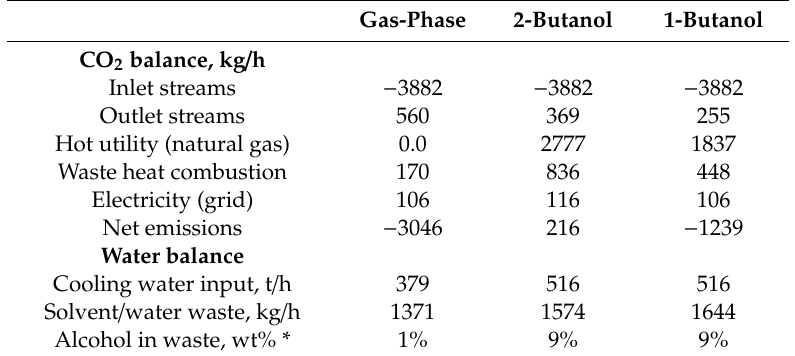
Table 7. CO 2 and water balance of the alternative CO 2 hydrogenation to methanol